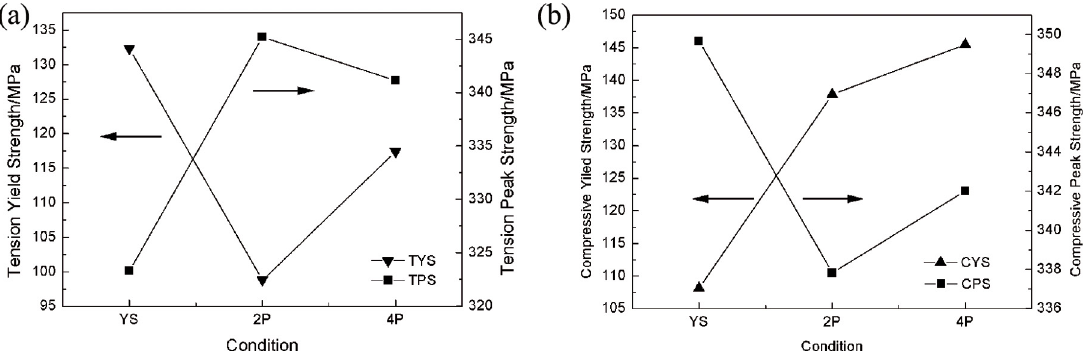
Figure 4. Tensile/compressive yield strength and peak strength on various pre-strained specimens important effect on the yield stage. In order to make clear the evolution of mechanical properties, microstructures on various pre-strain deformations are